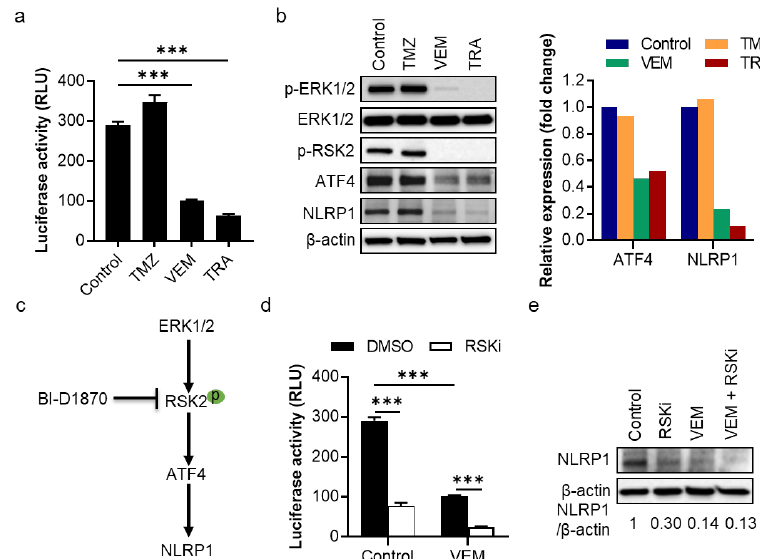
Figure 2. Effects of VEM, TRA, and the RSK inhibitor on NLRP1 gene promoter activity and protein expression in SK-MEL-28 cells. ( a ) Around ~1000 bp NLRP1 promoter region was cloned into a luciferase reporter vector and transfected into cells overnight, and cells were treated with 100 µ M TMZ, 1 µ M VEM, or 0.1 µ M TRA for 24 h before measuring luciferase activity. ( b ) Western blot analysis of ERK activation, p-RSK2, ATF4, and NLRP1 expression in cells treated with inhibitors for 24 h. The band densities of ATF4 and NLRP1 were quantitated and normalized to those of the corresponding loading control β -actin (right panel). ( c ) Hypothesized regulation of NLRP1 by the ERK pathway through RSK2. Arrows indicate the direction of signal transduction; bar stands for inhibition; and “p” in green oval represents phosphorylation. ( d ) NLRP1 promoter luciferase activity in cells treated with 1 µ M VEM and/or 10 µ M BI-D1870, an RSK inhibitor (RSKi), for 24 h. ( e ) Western blot analysis of NLRP1 expression in cells treated with 10 µ M BI-D1870 and/or 1 µ M VEM for 24 h. The band densities of NLRP1 were quantitated and normalized to those of the corresponding loading control β -actin. Representative images are shown and data expressed as the mean ± SEM, n = 4. *** p < 0.001.